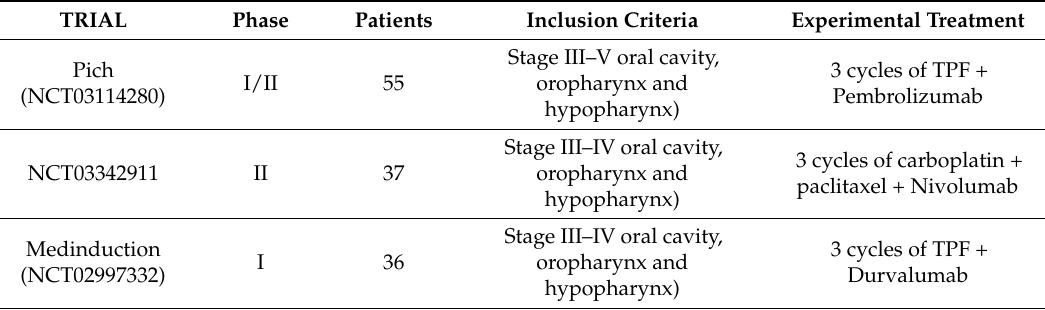
Table 2. Ongoing trials of induction chemotherapy in association with